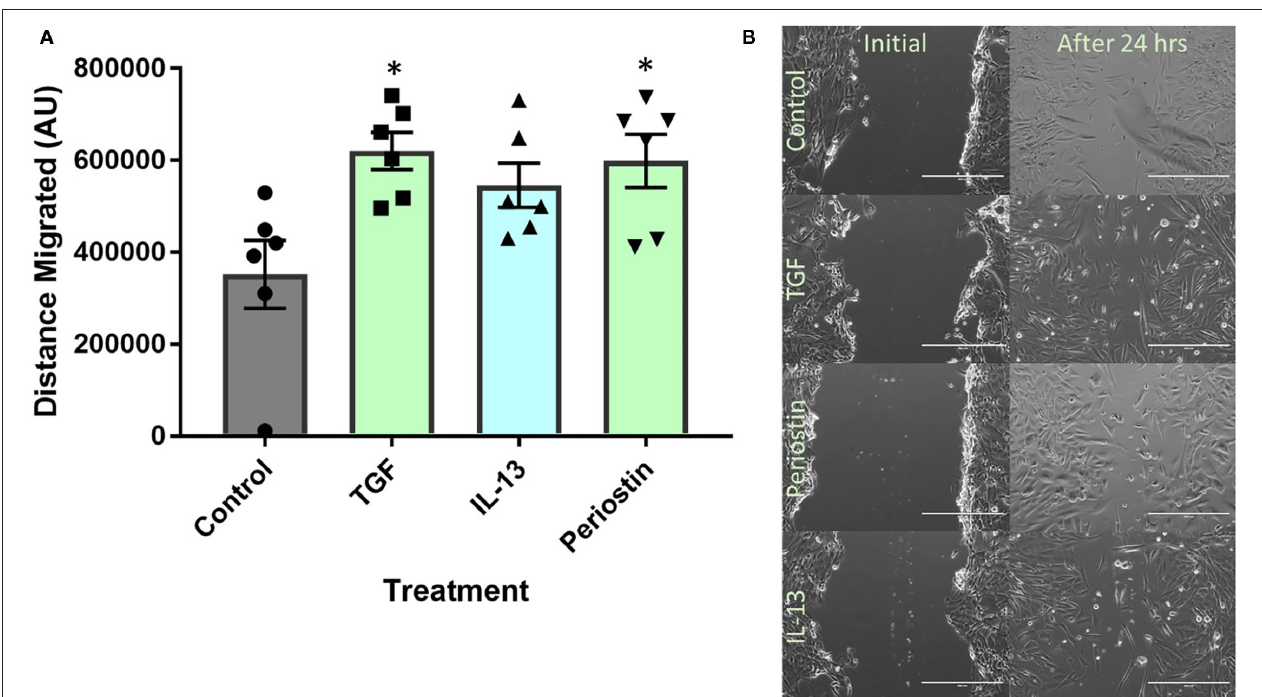
FIGURE 3 | Type 2 inflammatory mediators stimulate pericyte migration. (A) Scratch assay performed on pericytes that were grown in pericyte medium and treated with 10ng/ml of TGF- β , 100ng/ml of IL-13 or 100ng/ml of periostin for 48h. Cells were transferred into serum-free medium and a scratch was made in each monolayer using a p200 pipette tip. (B) Images were taken at 100x magnification immediately after scratching and 24h later. The scratch width was determined using ImageJ and the average distance of cell migration was calculated. n = 6 representative of two independent experiments, * p < 0.05 vs. untreated